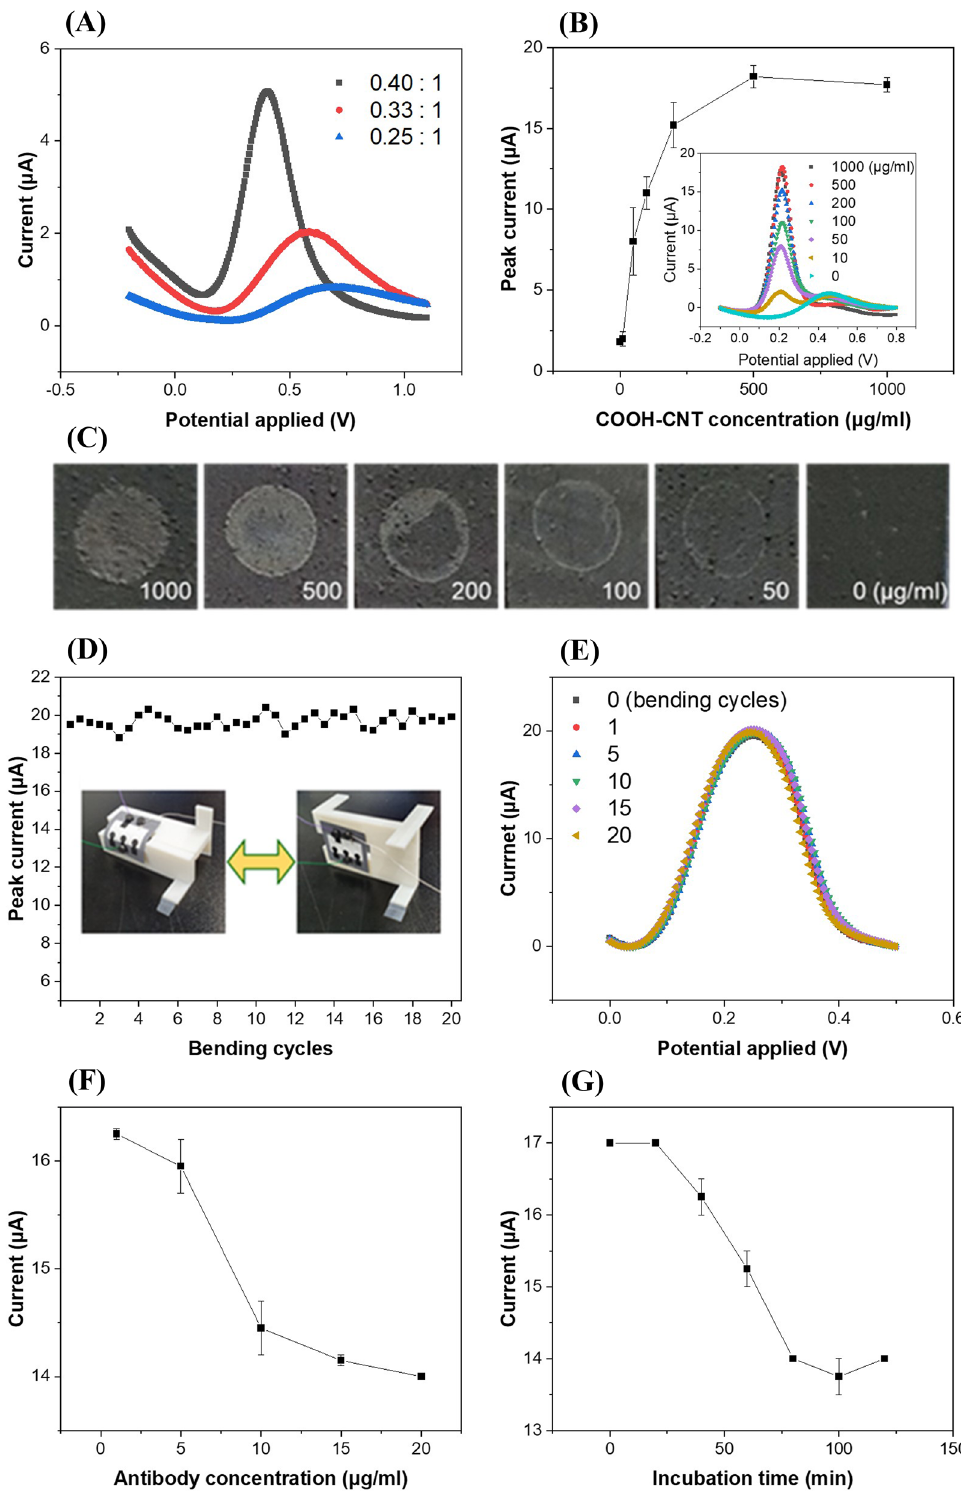
Figure 2. (A) Differential pulse voltammograms of screen-printed MWCNT-PDMS electrodes with different mixing ratios of MWCNT and PDMS. (B) Peak currents measured for various concentrations of COOH-CNTs. The inset shows the differential pulse voltammograms for each deposition concentration of COOH-CNT on the working electrode. (C) Photograph of the working electrodes after placing 2 µl of dimethylformamide containing carboxyl-functionalized single-walled carbon nanotubes (COOH-CNTs) for different concentrations ranging from 0 to 1000 µg/ml, followed by curing in an oven at 100 °C. (D) Peak currents of the COOH-CNT/MWCNT-PDMS electrodes measured with repeating bending and unfolding for 20 cycles. The inset shows the photographs of the bending test setup. (E) Differential pulse voltammograms of the COOH-CNT/MWCNT-PDMS electrodes at 1, 5, 10, 15, and 20 bending cycles. (F) Peak currents measured for different antibody concentrations on the working electrodes (incubation time = 120 min, concentration: 1, 5, 10, 15, and 20 µg/ml). (G) Peak currents measured for antibody incubation times (concentration: 10 µg/ml, t = 0, 20, 40, 60, 80, 100, and 120 min, temperature = 37